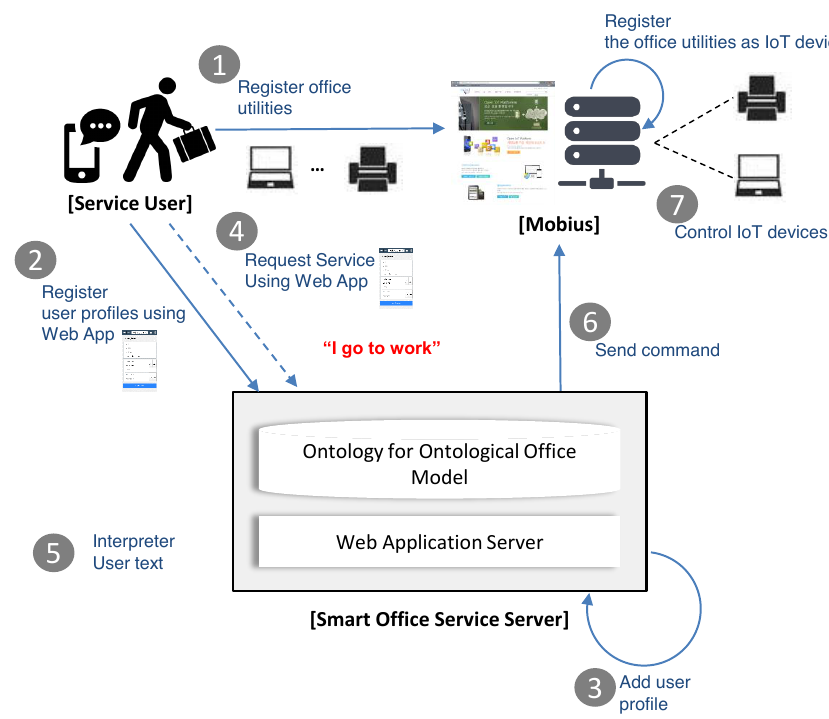
Figure 7. The service flow for the prototype service for the smart